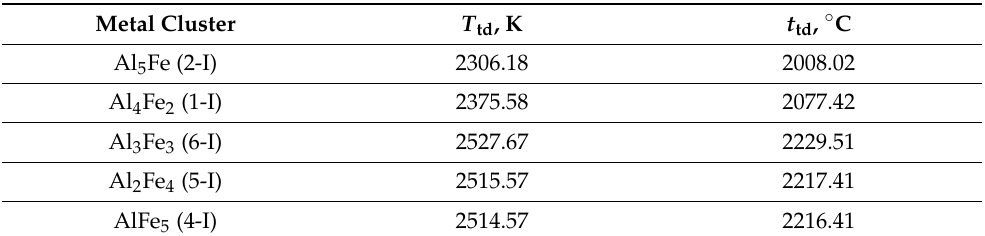
Table 14. Temperatures of the beginning of thermal destruction ( T td , K) and ( t td , ◦ C) of the most energetically-stable metal clusters of Al n Fe m (n + m =